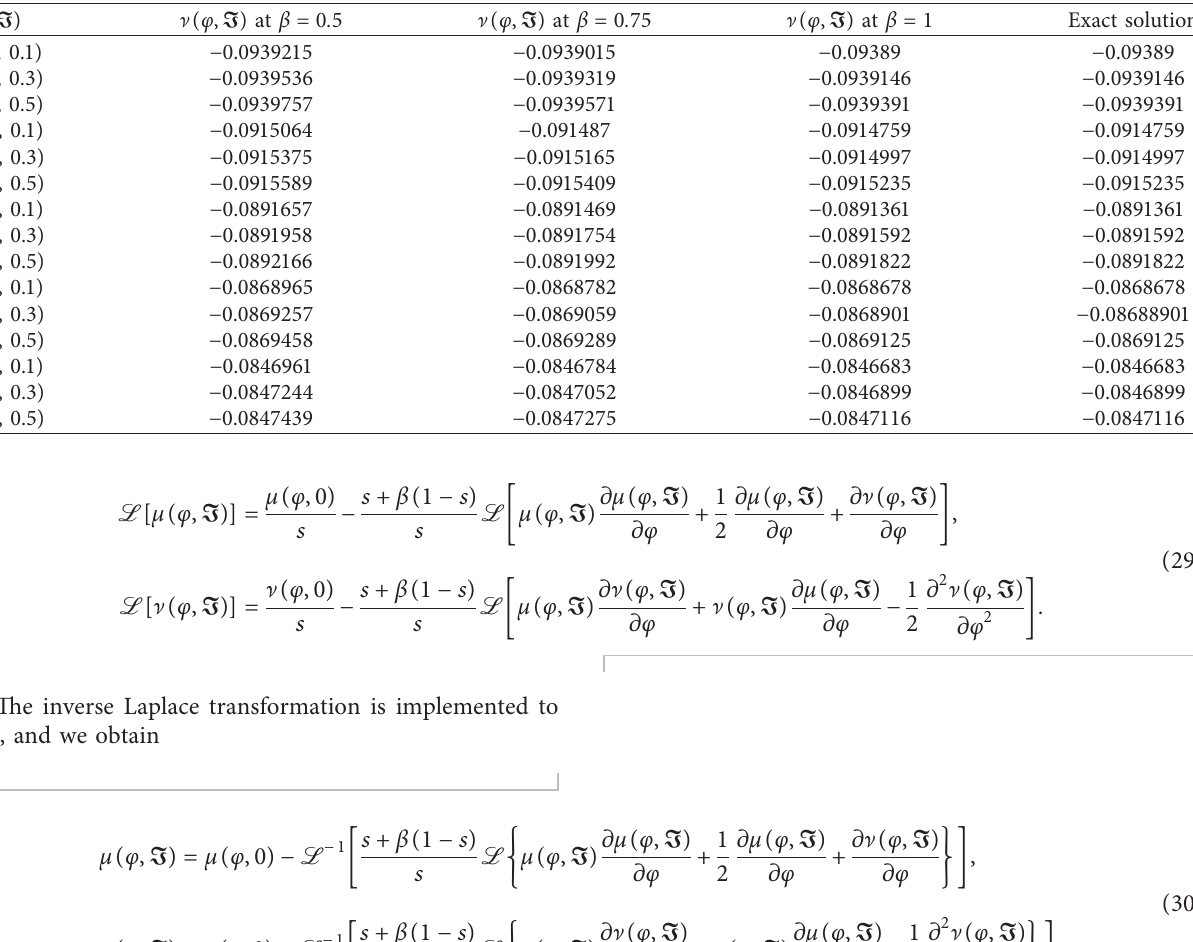
Table 2: HPTM for the approximate solution of Example